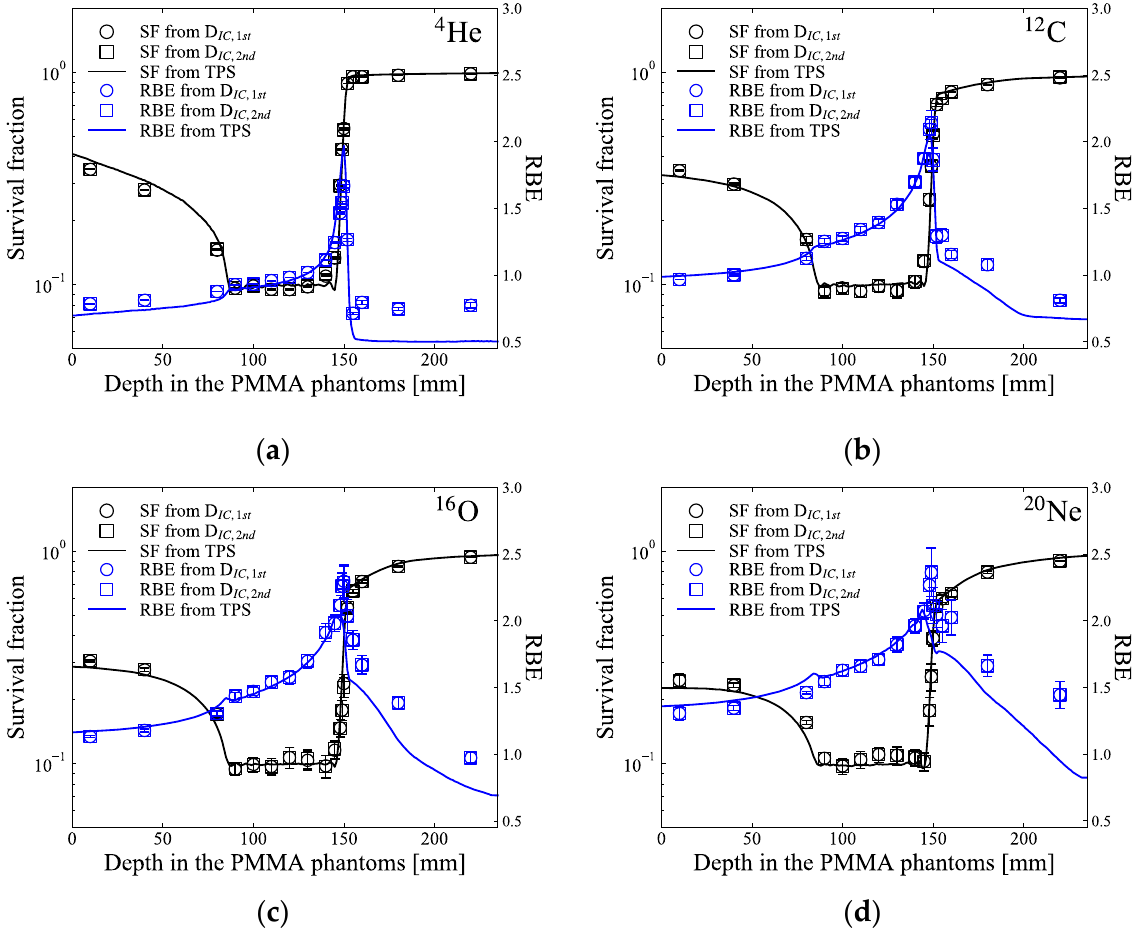
Figure 5. The black markers indicate the predicted SF of HSGc-C5 cells along the SOBP of ( a ) 4 He-, ( b ) 12 C-, ( c ) 16 O-, and ( d ) 20 Ne-ion beams. Blue markers indicate the estimated RBE of the HSGc-C5 cells along the SOBP. The black and blue solid lines present the planned survival fraction and RBE, respectively. Each error bar corresponds to the uncertainties of the SF and RBE evaluated from the error in lineal energy using error propagation.